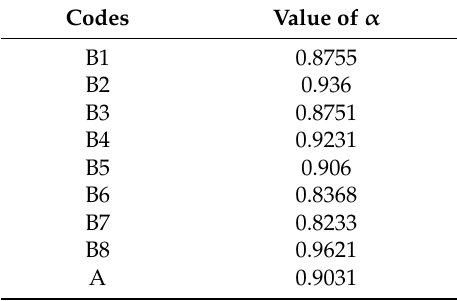
Table 9. The value of α of the